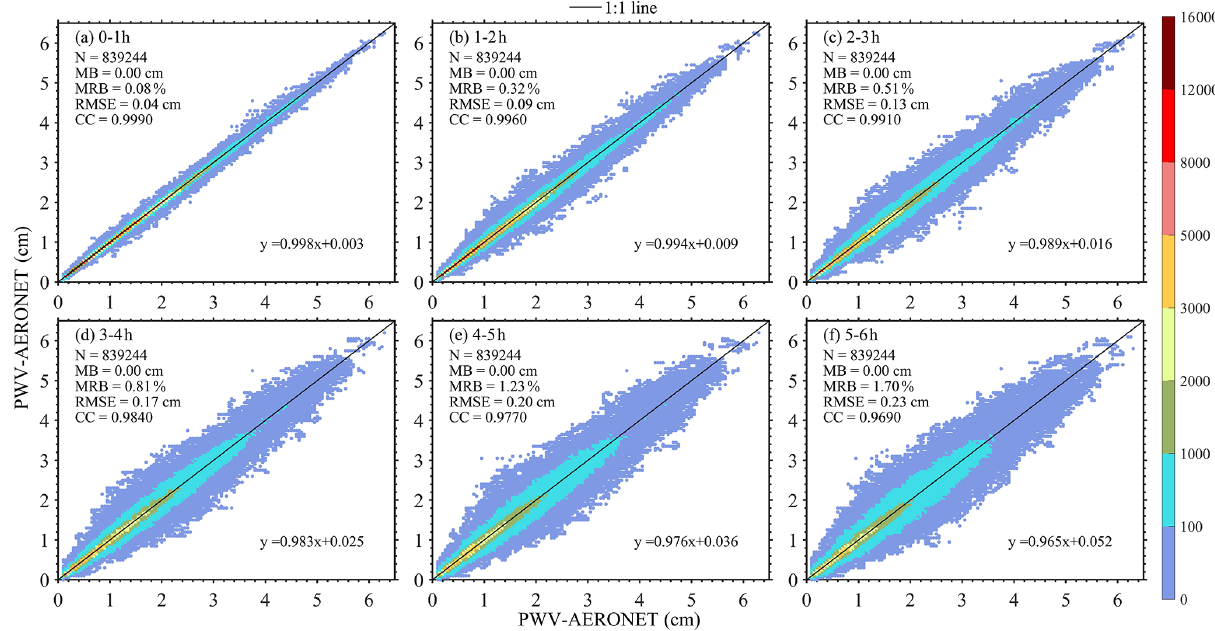
Figure 1. Scatterplots of PWV derived from AERONET in different temporal discrepancy intervals; panels (a) – (f) present the temporal discrepancy of 0–1, 1–2, 2–3, 3–4, 4–5, and 5–6h, respectively. The solid line represents the 1:1 line. The color bar depicts the number density of matchups for each bin of PWV in a 0.01cm × 0.01cm grid.